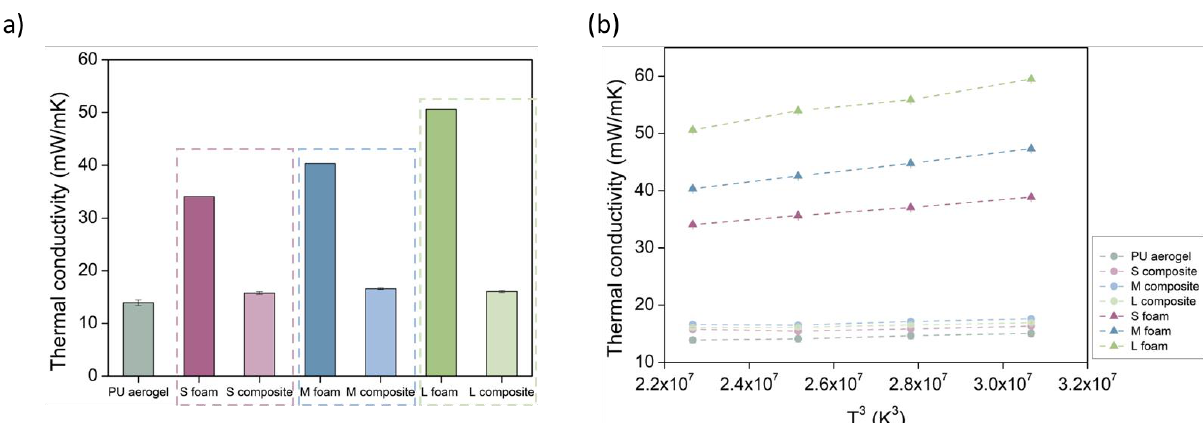
Figure 10. ( a ) Thermal conductivities for all the samples at 10 ◦ C, ( b ) representation of thermal conductivity vs. T 3